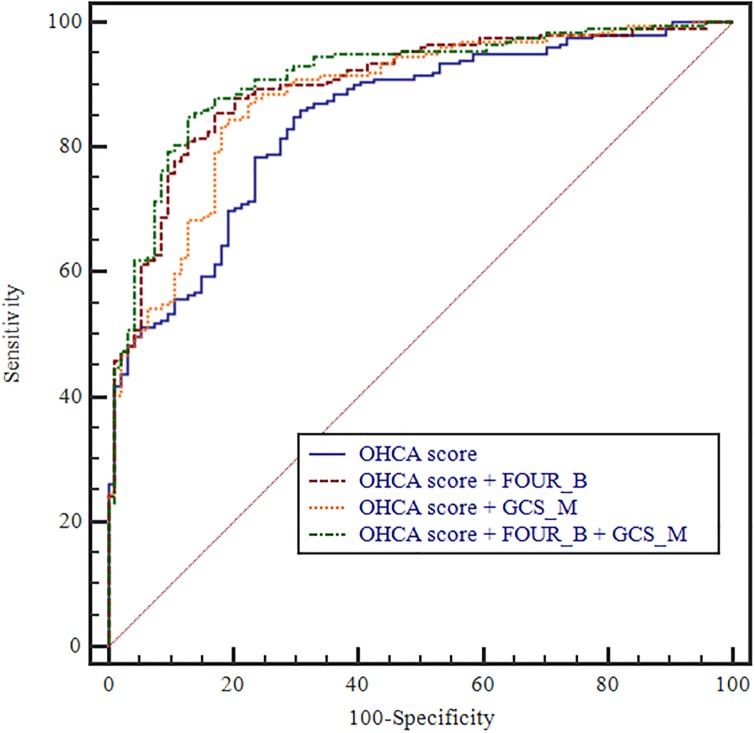
Prognostic value of OHCA score for the prediction of poor neurologic outcome after CA.[1] OHCA score (AUC 0.844, 95% CI 0.798–0.884); [2] OHCA score with FOUR_B (AUC 0.899, 95% CI 0.858–0.931); [3] OHCA score with GCS_M (AUC 0.880, 95% CI 0.837–0.915); [4] OHCA score with FOUR_B and GCS_M (AUC 0.911, 95% CI 0.873–0.941).